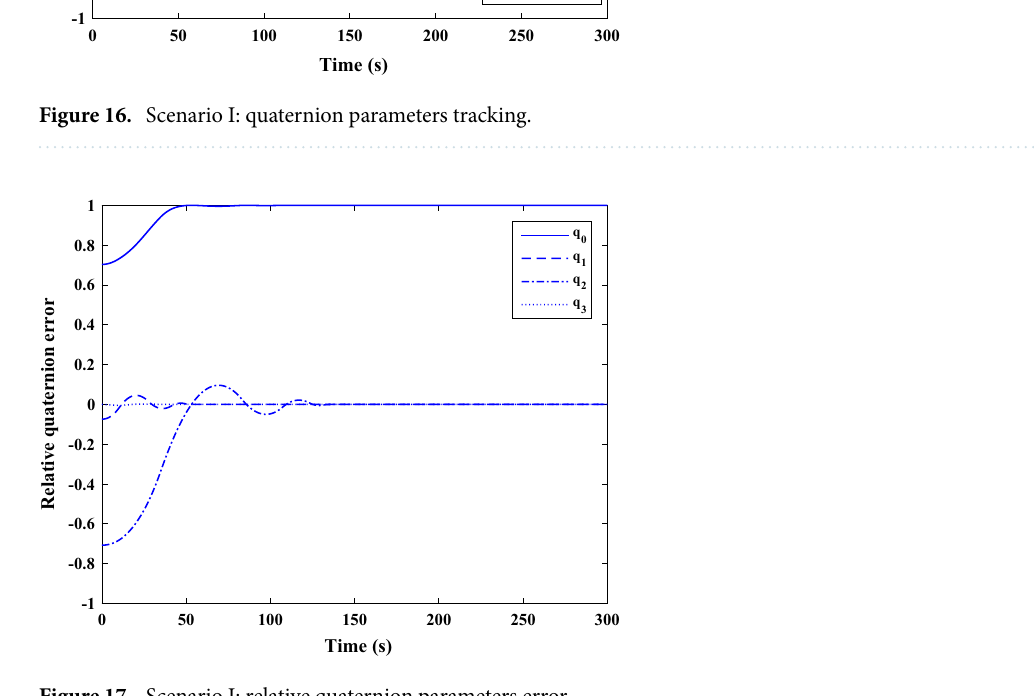
Figure 17. Scenario I: relative quaternion parameters error.